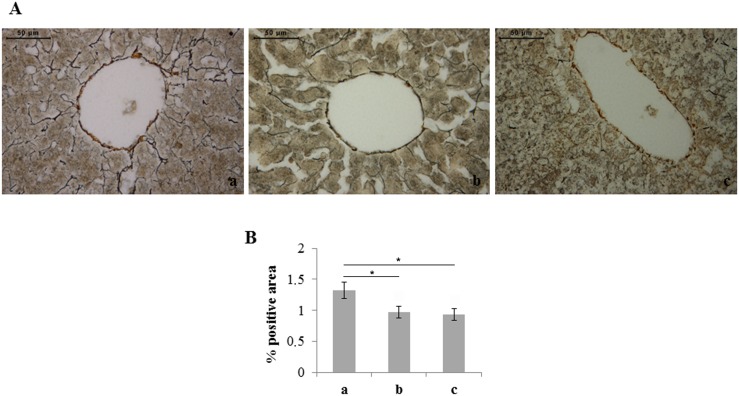
Moderate and severe hyperoxia reduces the amount of reticular fibers in rat liver.A) Silver staining of neonatal rat livers exposed to moderate and severe hyperoxia. Reticular fibers are labeled by black stain. In livers of rats exposed to moderate and severe hyperoxia a lower amount of reticular fibers is visible. a) ambient air; b) 60% hyperoxia; c) 95% hyperoxia. Scale bar: 50 µm, magnification 40x. B) Graphic representation of the percentage area of reticular fibers (±SD); densitometric analysis determined by quantifying thresholded area for black color in ten fields for each of three slides per sample. * = p<0.05.